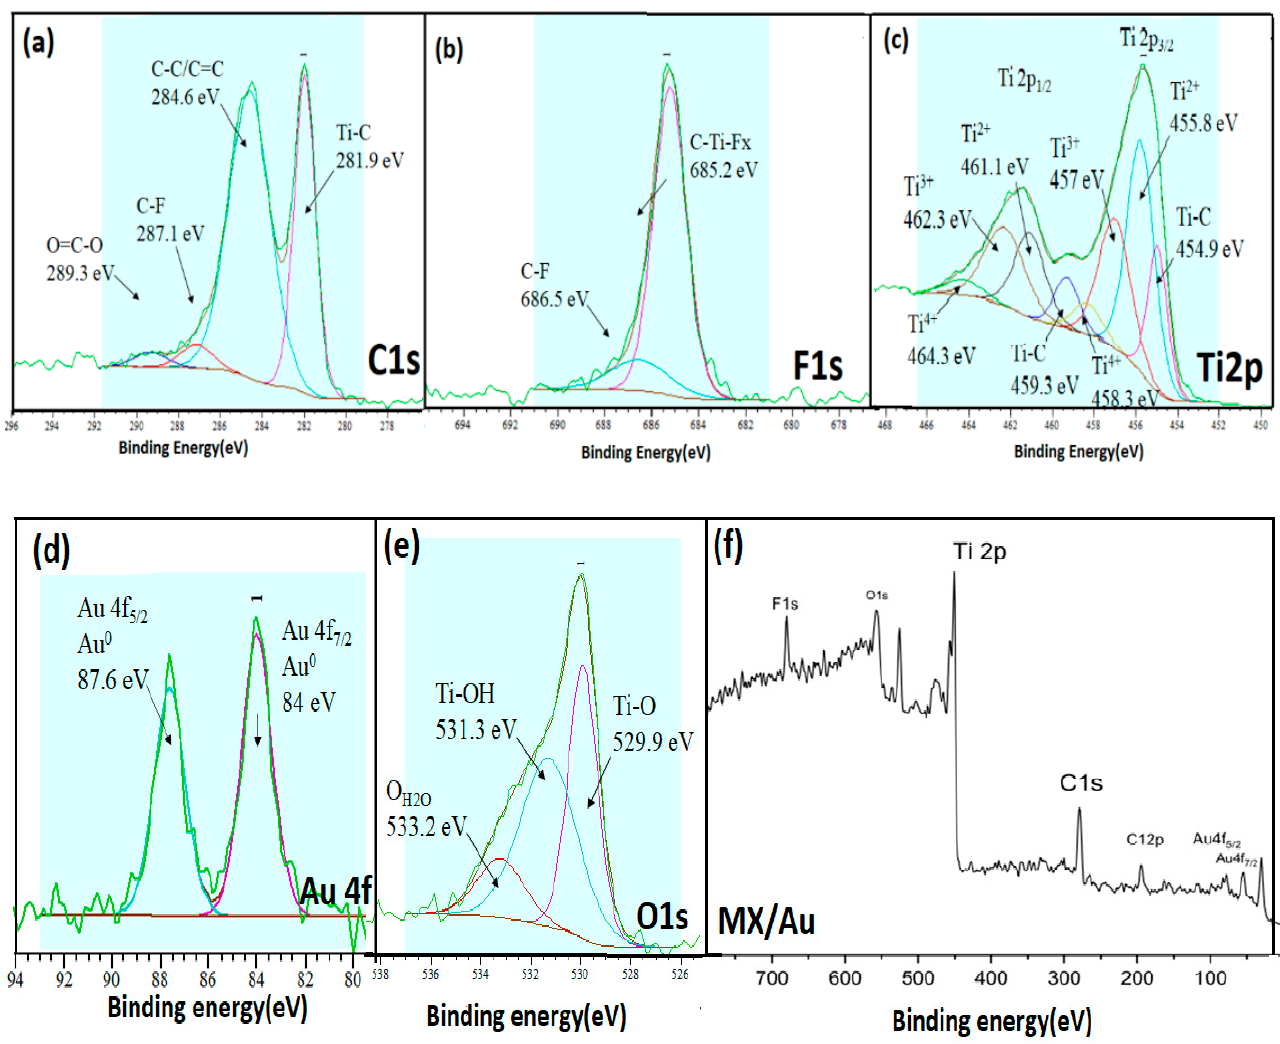
Figure 4. High resolution XPS spectra of ( a ) C 1s of MX/AuNPs; ( b ) F 1s; ( c ) Ti2p; ( d ) Au 4f; ( e ) O 1s; ( f ) survey spectra of MXene/AuNPs film.